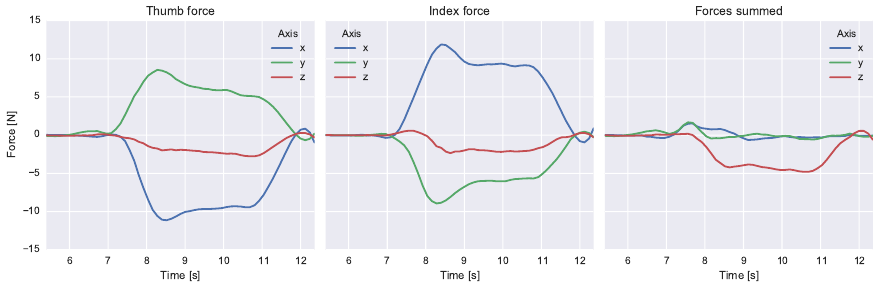
Figure 5. Experiment 1: lifting a mass load (0.44 kg); the forces of the index finger ( left ) and thumb ( middle ). In addition, the summed forces are displayed ( right ). All signals are expressed in the global coordinate